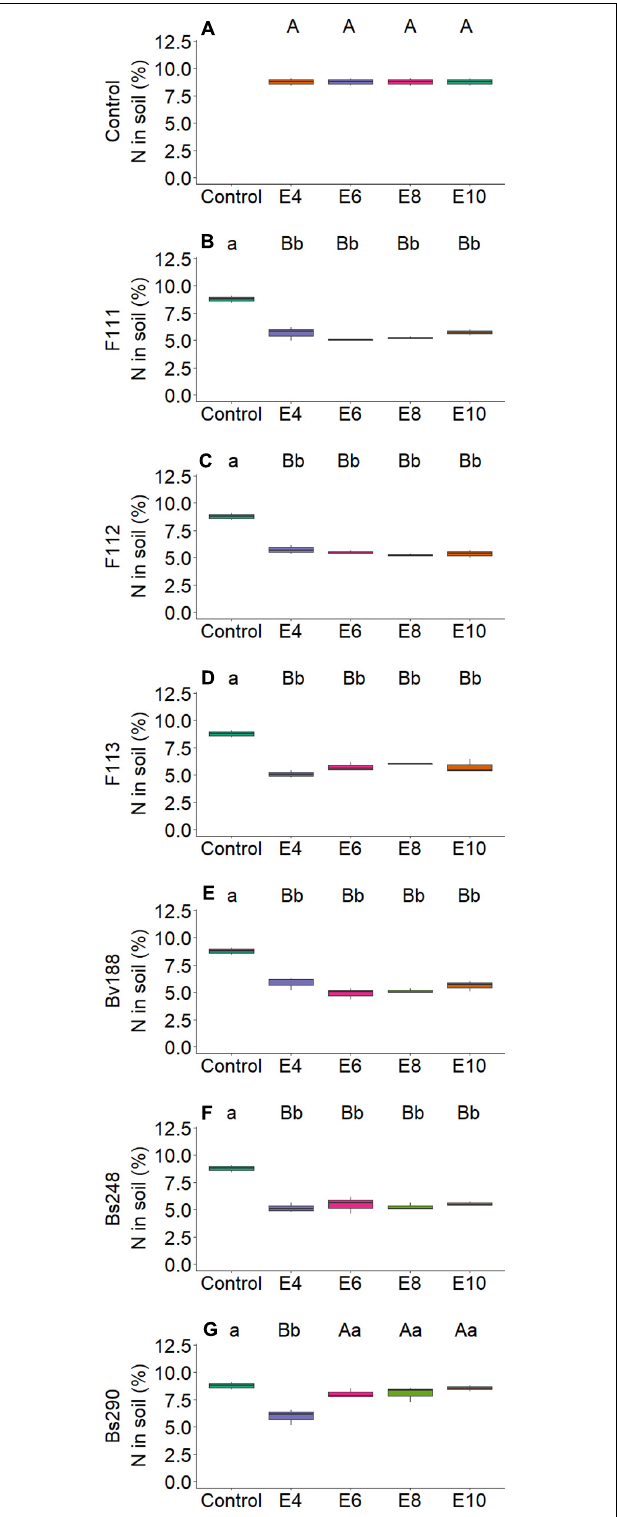
FIGURE 5 | Boxplots (median and quartiles) of percentage of nitrogen in soil sown with cotton and inoculated with plant